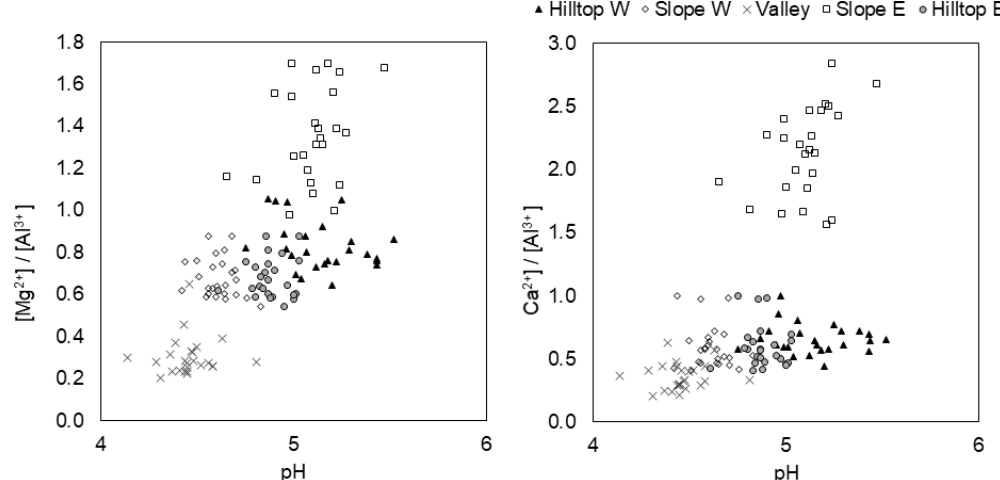
Figure 4. Comparison of Ca / Al and Mg / Al vs.